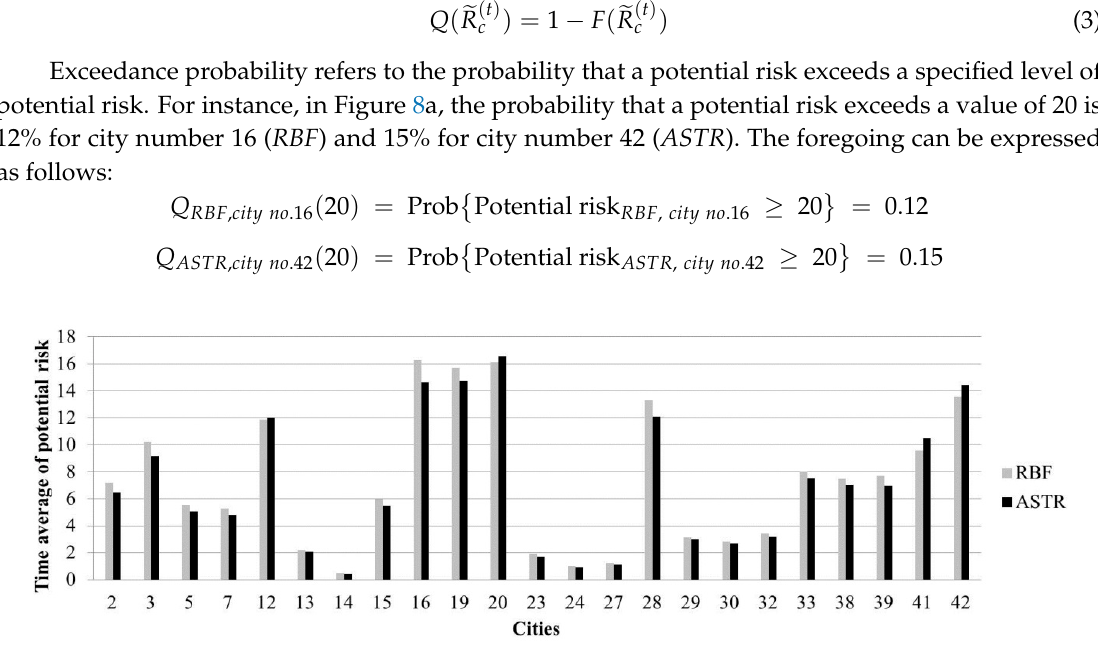
Figure 7. Time average of potential risk ( (cid:1844) (cid:1855)((cid:1872)) ) of cities for two MAR sites from 2001 to 2014.